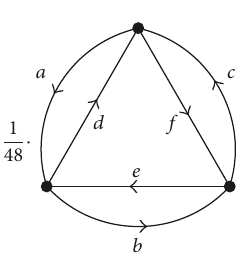
Figure 2: The only 2PI four-loop diagram (symmetry factor 1/48 , 𝑅 = 5/108 = 0.0463 ).